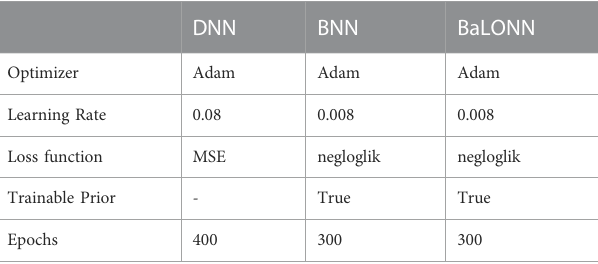
TABLE 4 Main model parameters used in the current